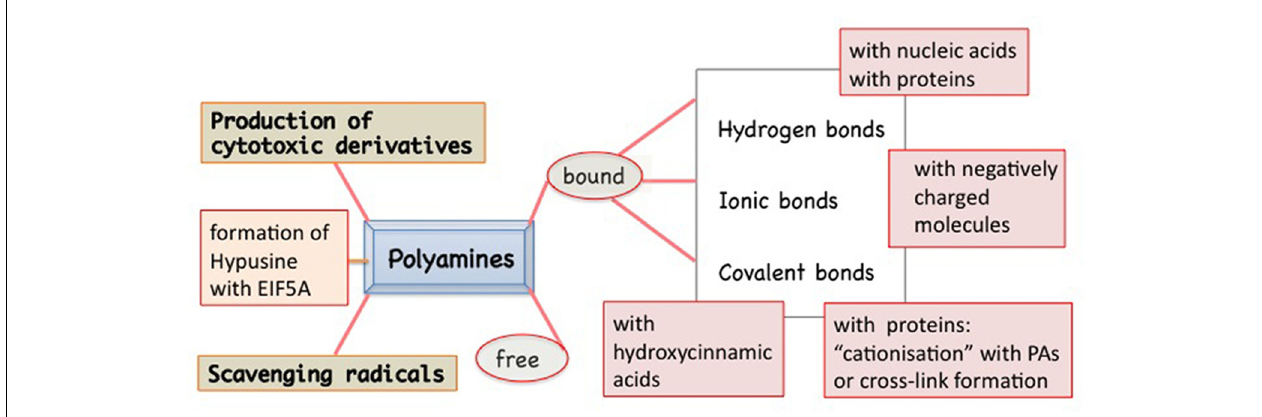
hydroxycinnamic acids. PAs are also actively metabolized: from PU to SD and SM but also vice versa. In addition, they can give rise to cytotoxic derivatives. PAs can act as free radicals. SD can be metabolized, by removing the aminopropyl group, and linked to a lysyl residue of the EIF5A precursor thus forming a peculiar derivative, the